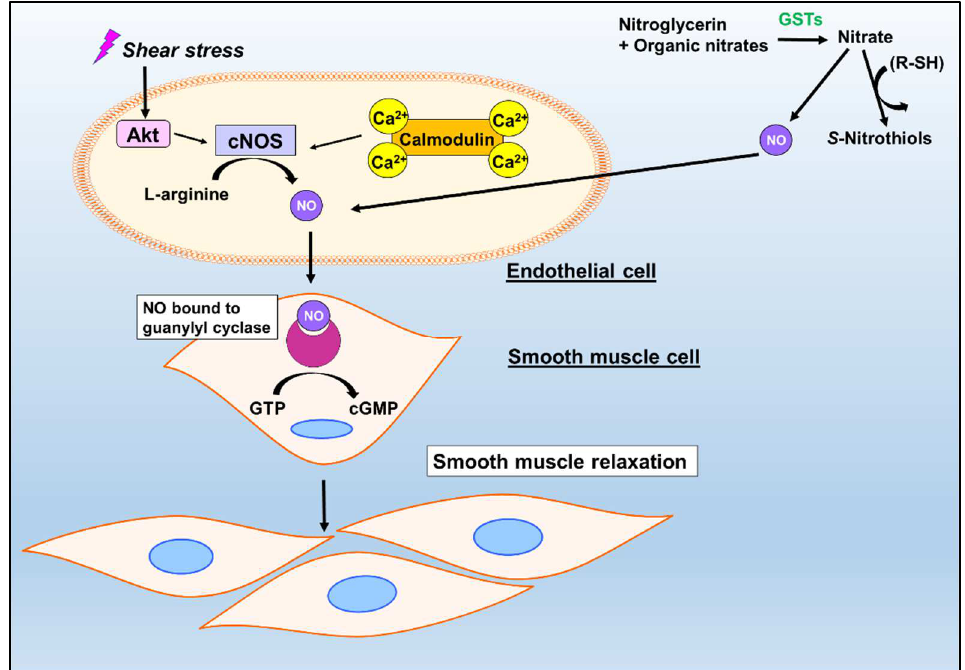
Figure 2. Schematic of the NO and potential GST-mediated regulation of vasorelaxation via sGC activation. Upon activation of constitutive nitric oxide synthases (cNOS; composed of endothelial and neuronal NOS) by calmodulin and calcium, cNOS can catalyze the conversion of L-arginine to L-citrulline to generate NO [37–40]. The production of NO can also result from the breakdown of organic nitrates, such as nitroglycerin [11–14]. NO facilitates the activation of sGC and the subsequent conversion of GTP to cGMP for vasodilation [37–40].